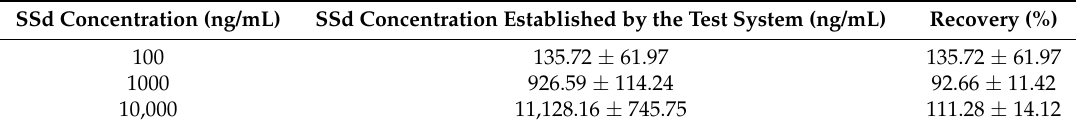
Table 2. Recovery rate of SSd.